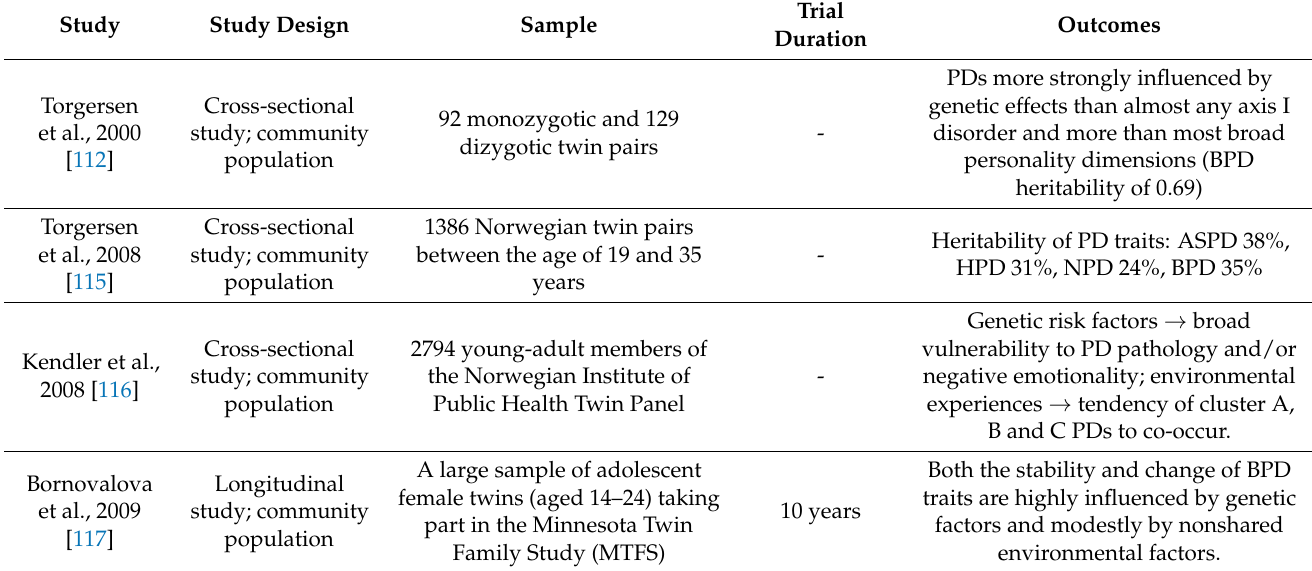
Table 3. Studies on genetic and neurobiological